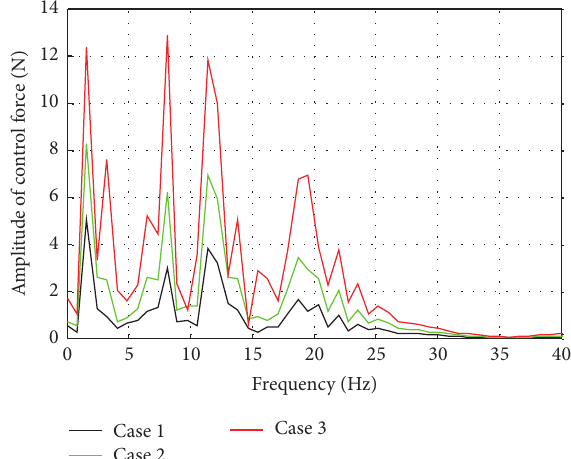
Figure 15: Amplitude of control force at different